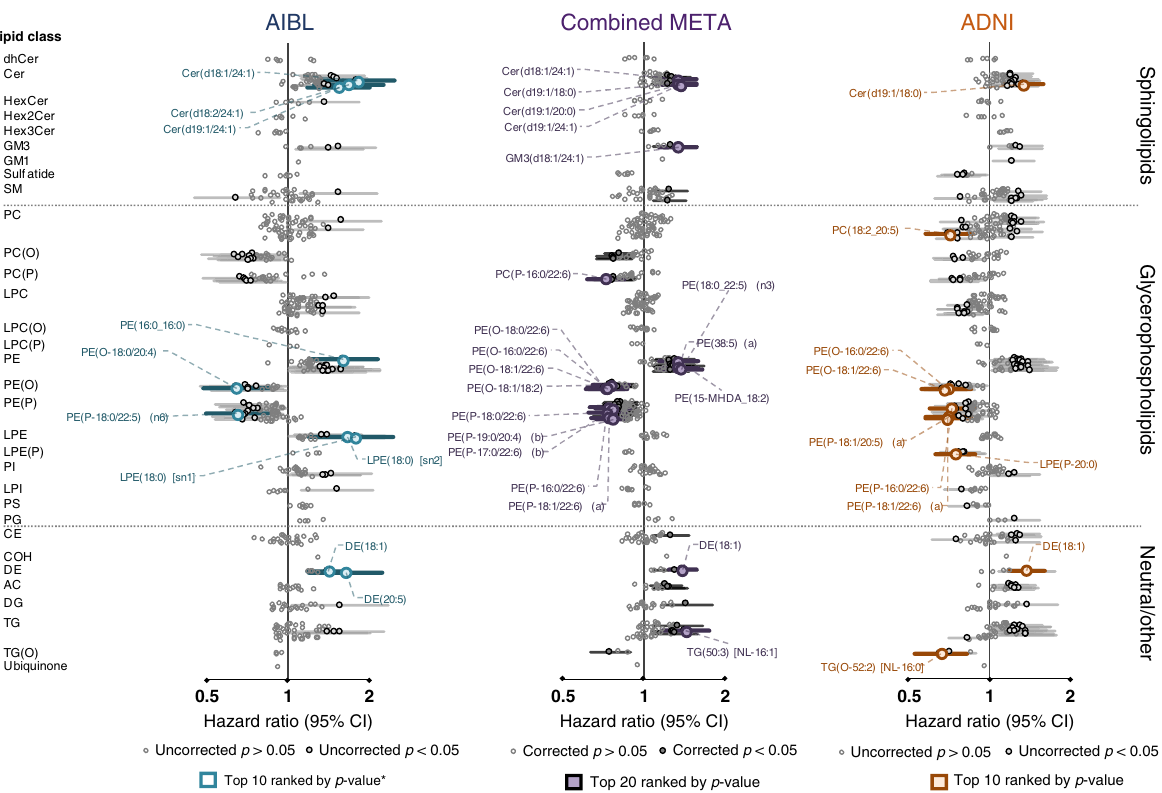
Fig. 4 Associations of individual lipid species with future onset Alzheimer ’ s disease. Forest plot outlining the Cox regression results of individual species, between non-converters and future converters in both the AIBL (cyan n = 68 cases, 714 controls) and ADNI (orange, n = 166 cases, 397 controls) cohorts with the combined meta-analysis in the middle (purple). P value was corrected for multiple comparison using approach by Benjamini and Hochberg. Covariates include age (set as timescale), sex, BMI, total cholesterol, HDL-C, triglycerides, number of APOE4 alleles, statin use and omega-3 supplementation. Open circles, not signi fi cant; closed dark circles, uncorrected p value; coloured squares, top 10/20 associations ranked by p